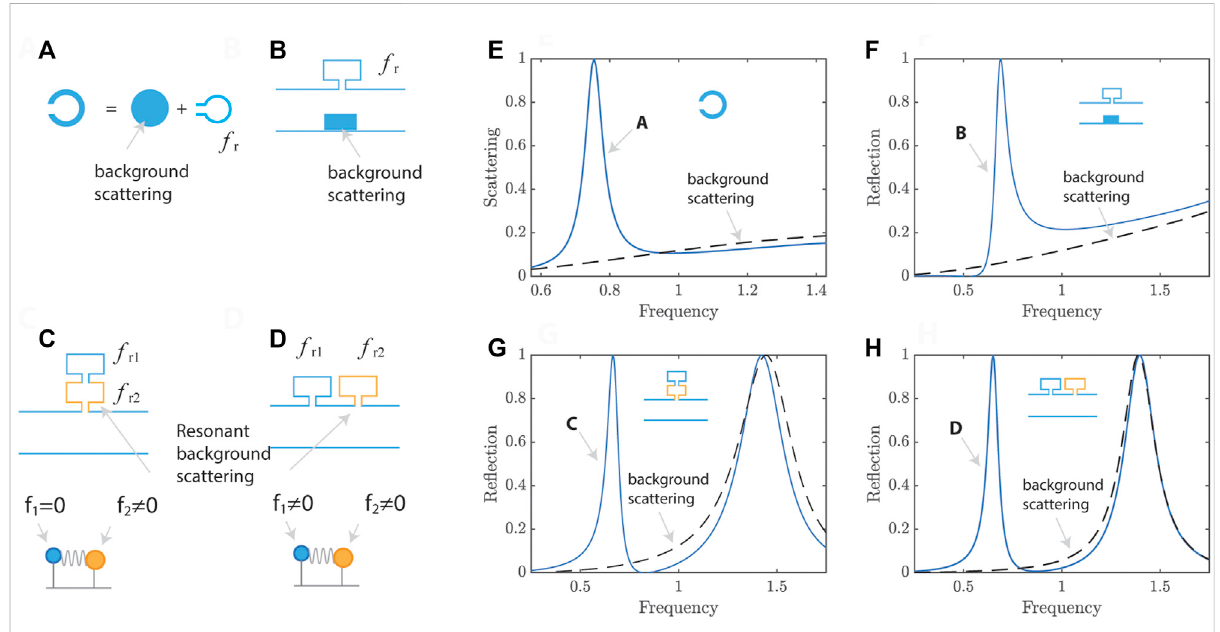
FIGURE 10 Different types of Fano resonances. (A) Resonant scatterer having non-resonant background scattering and resonant scattering ( f r ) in a free fi eld. (B) Resonator and non-resonant scatterer in awaveguide. (C) Dual resonators in awaveguide having a resonant background scattering ( f r a narrow band resonant scattering ( f r 1 ). Only the resonator having background scattering is excited ( f 1 = 0 and f 2 ≠ 0). (D) Dual resonators stacked alongthewaveguide.Bothresonatorsareexcited(